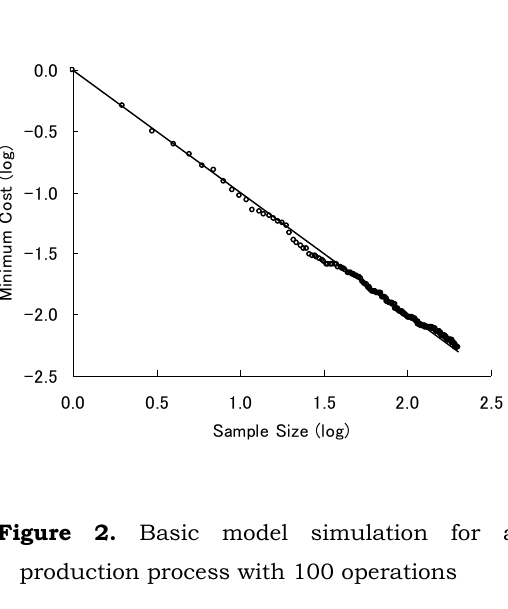
Figure 2. Basic model simulation for a production process with 100 operations Source: Takahashi (2001), Figure